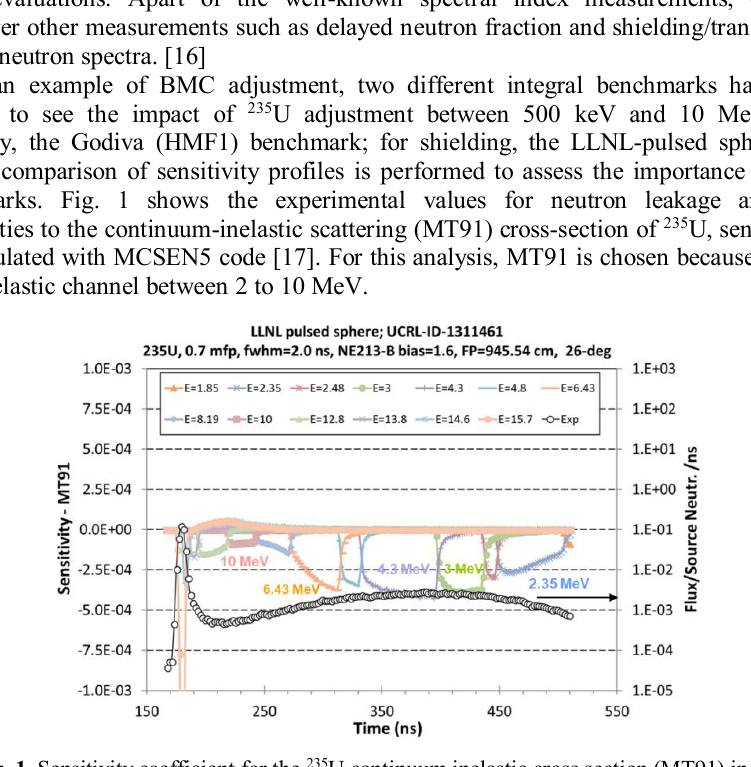
Fig. 1. Sensitivity coefficient for the 235 U continuum inelastic cross section (MT91) in the LLNL/235U pulsed sphere. Sensitivity calculation performed with MCSEN5